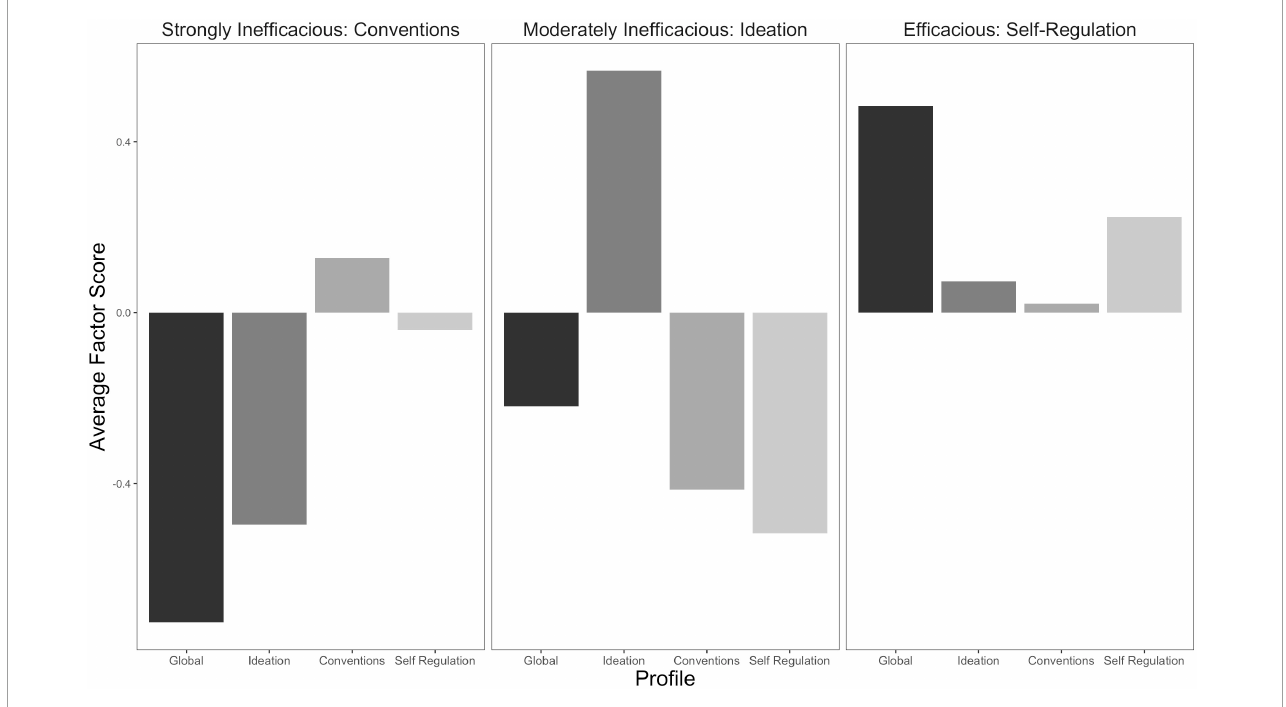
FIGURE2 Latent profile model based on bifactor factor scores of the Self-Efficacy for Writing Scale (SEWS).